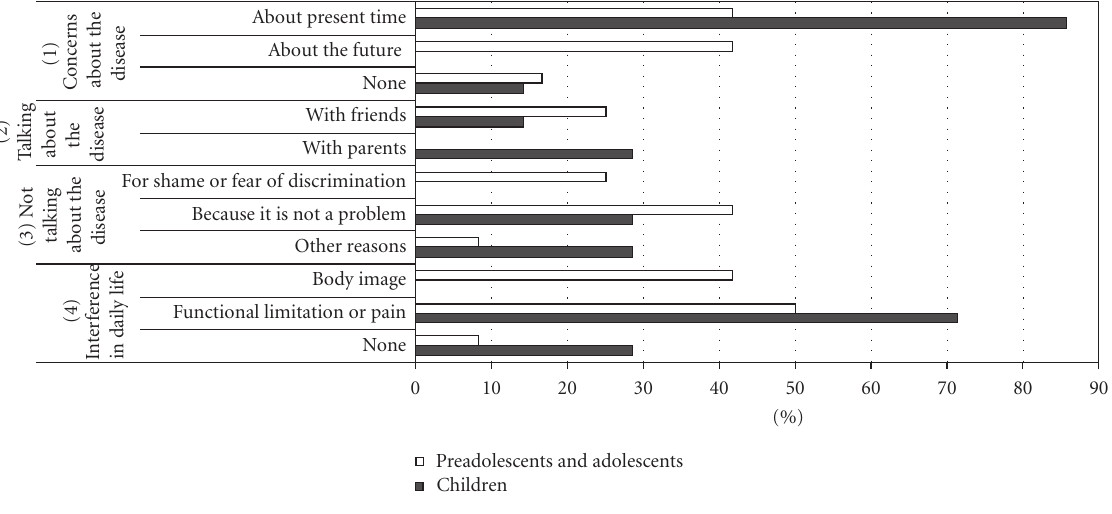
Figure 3: Experience of